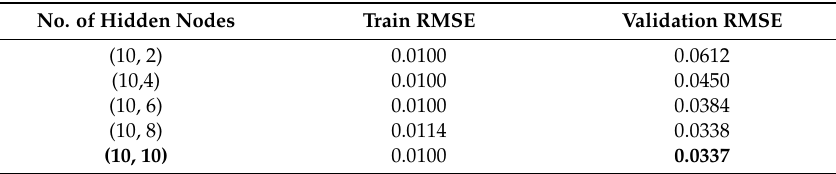
Table 6. Performance comparison of a two hidden layer neural network by varying the number of nodes in the last hidden layer. The first and the second elements of the No. of Hidden Nodes are node number of the first and the second hidden layers, respectively.